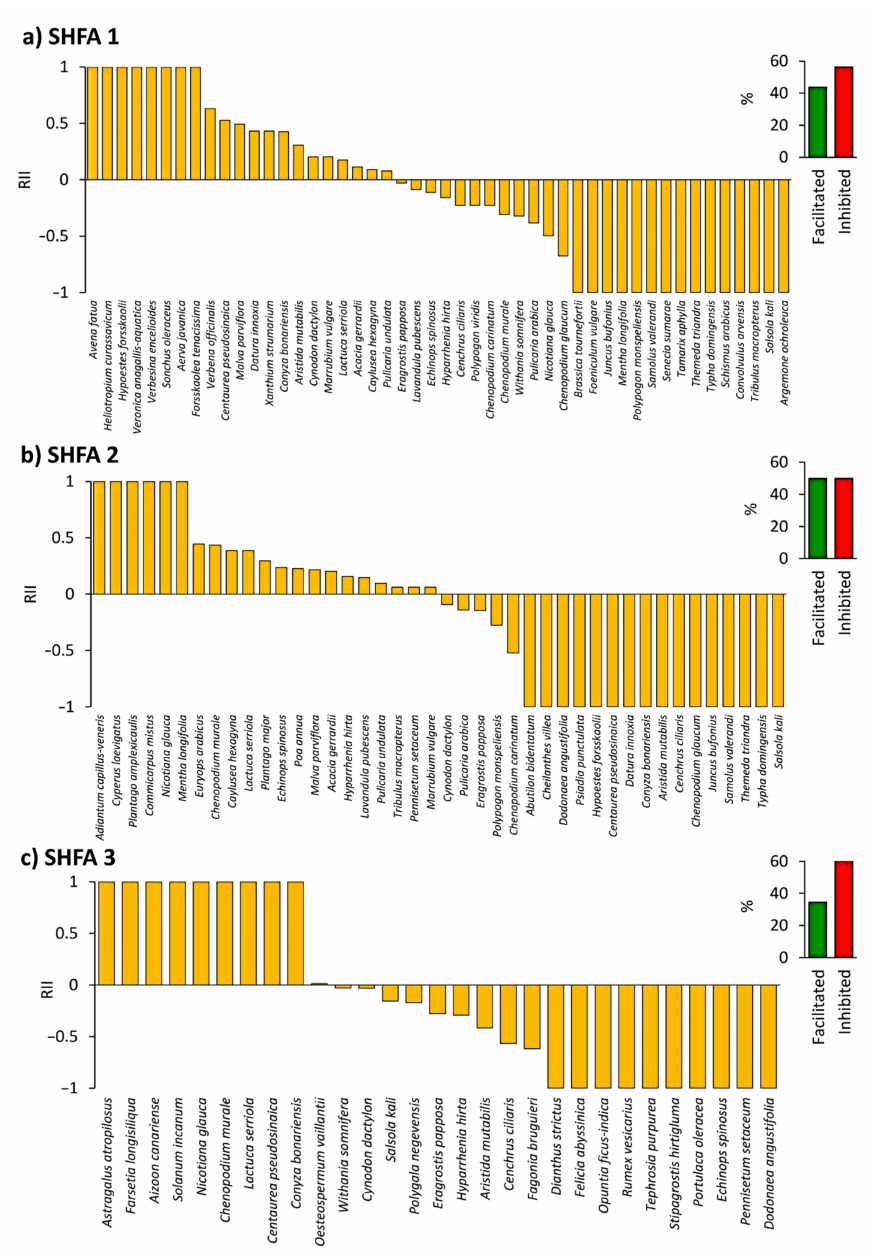
Figure 5. The influence of Nicotiana glauca on the native understory species in the Ash-shafa (SHFA) locations [( a ) SHFA 1, ( b ) SHFA 2 & ( c ) SHFA 3], Taif region, western Saudi Arabia. RII: relative interaction index with ranges from − 1 (showing negative effects) to +1 (facilitation). The percentage of facilitated or inhibited species within each location is shown to the right of the histograms. By calculating the totally inhibited (only recorded outside canopy of N. glauca ) and totally facilitated (only recorded under canopy) species within each location, it is clear that the number of totally inhibited species was higher than facilitated species (Figure